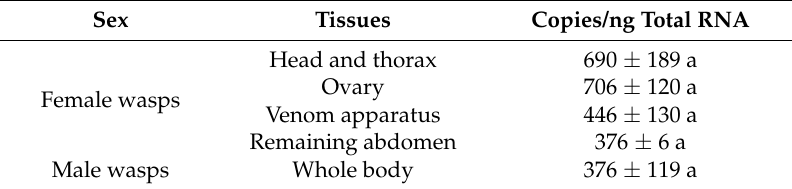
Table 4. Viral loads of TbRV-1 in different tissues of T. brontispae wasps.